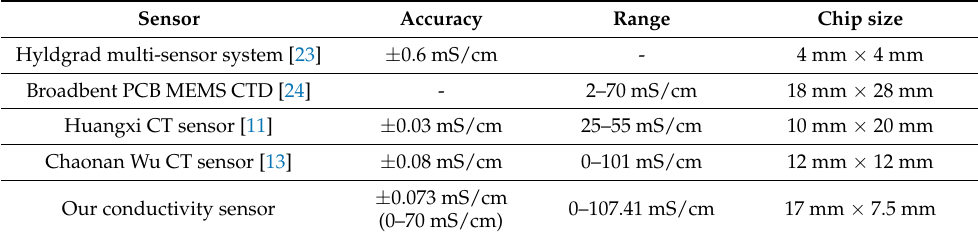
Figure 14. The graph shows the measurement error of the sensor. Table 1. Comparison of our conductivity sensor and other